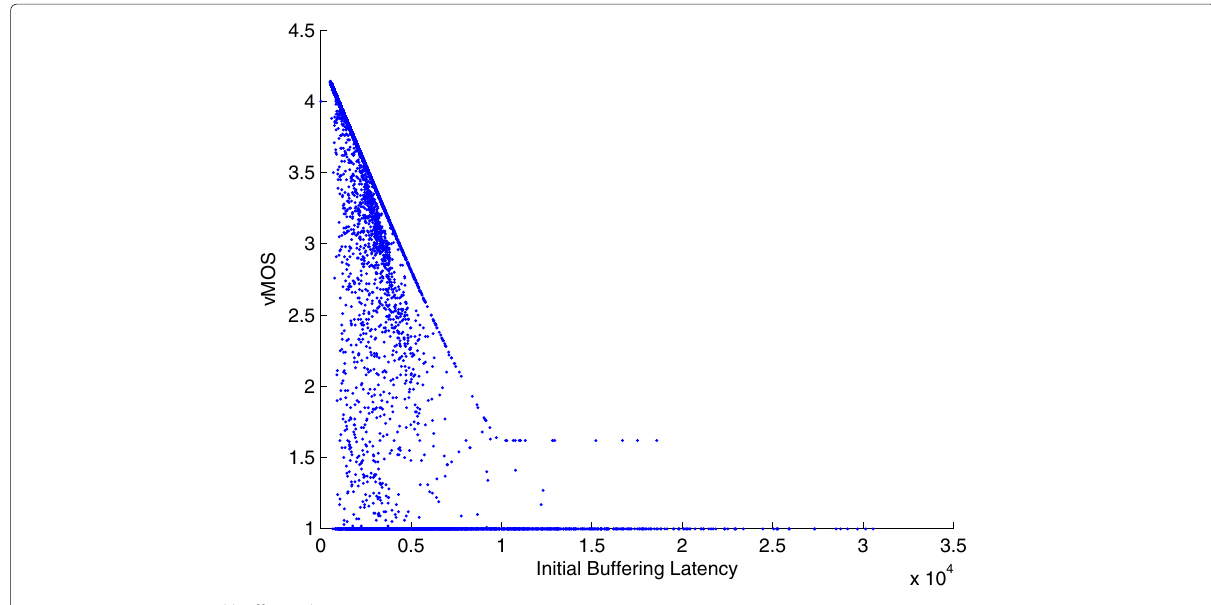
Fig. 3 vMOS versus initial buffering